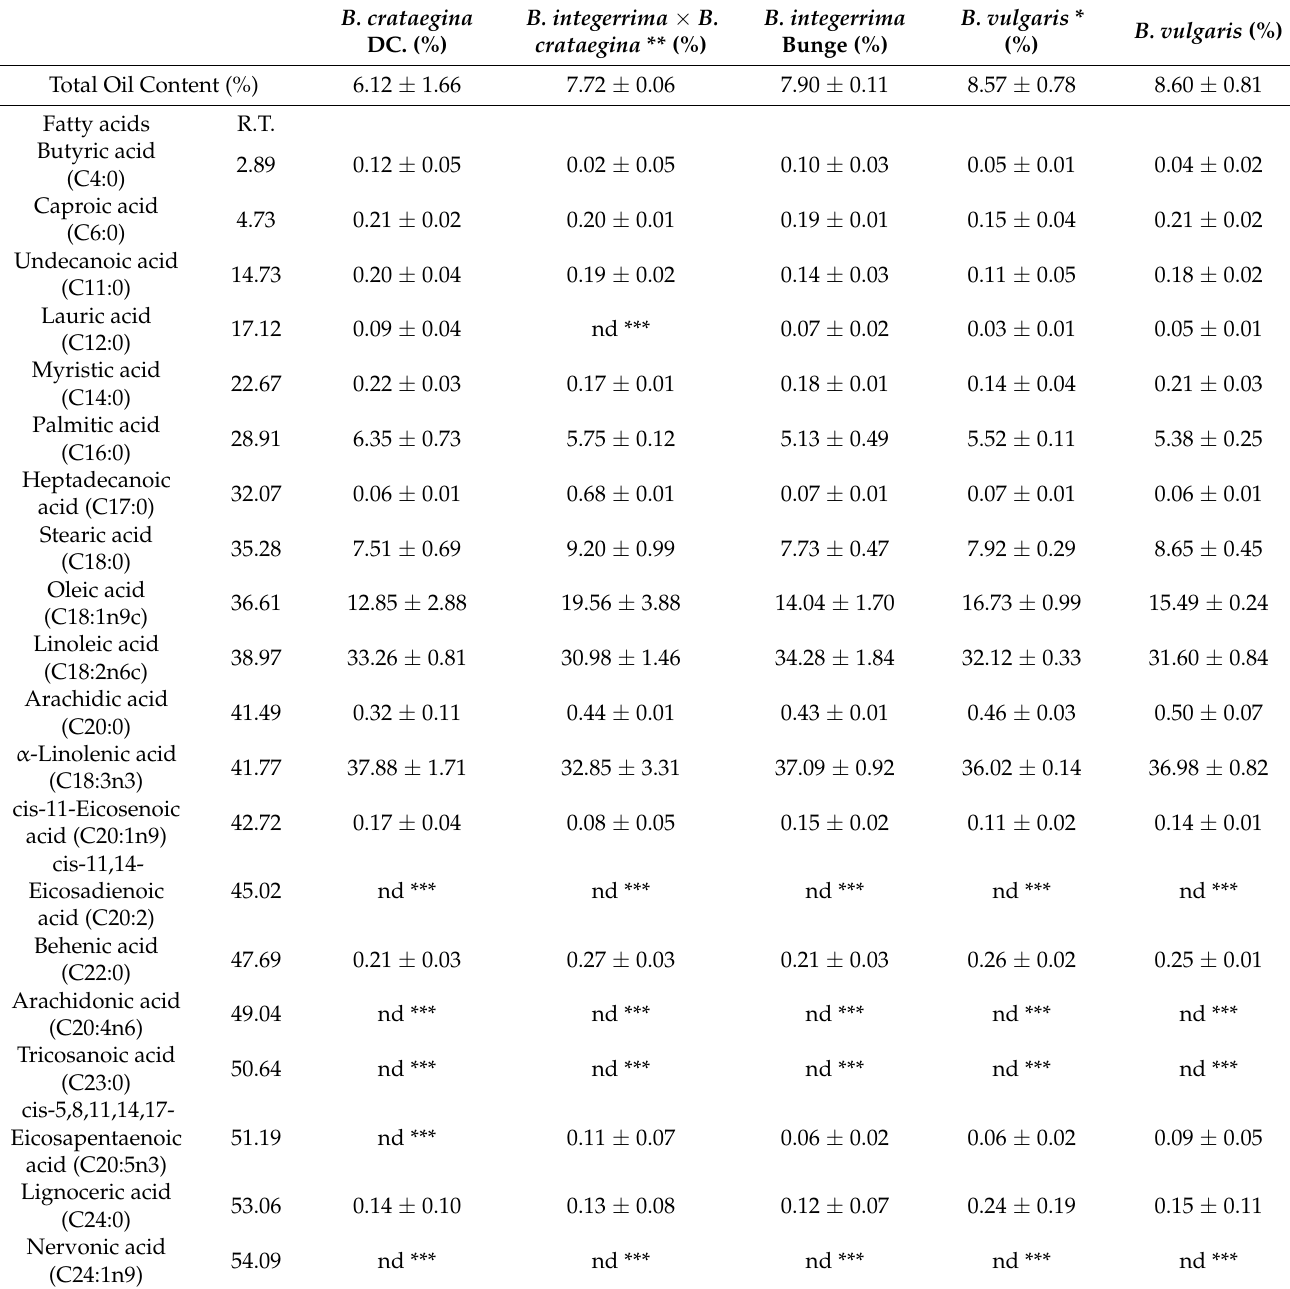
* Culture plant ** Hybrid *** nd: not